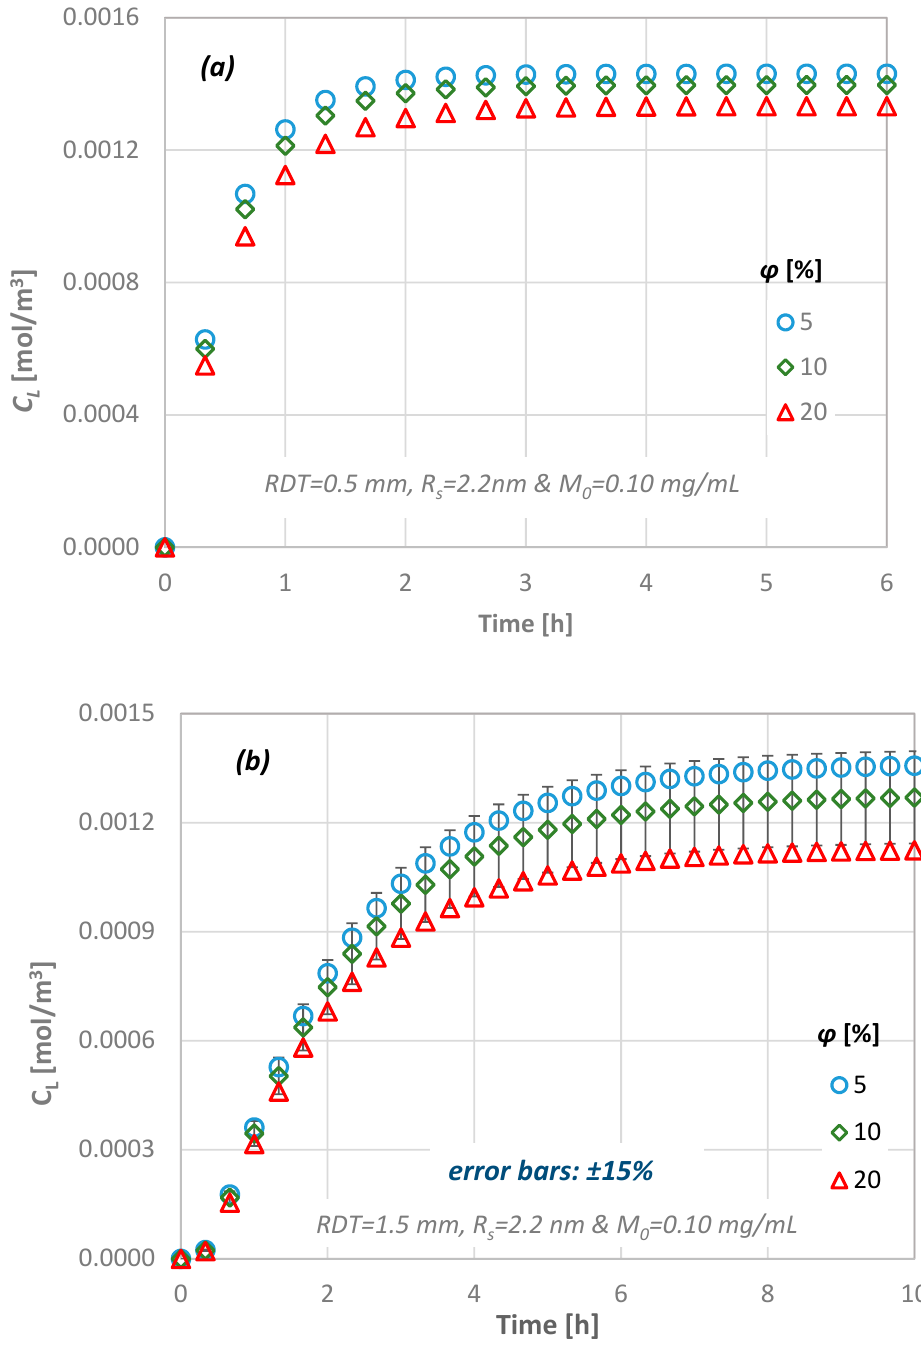
Figure 11. Effect of the dentinal disc porosity value on the diffusion characteristics for: ( a ) RDT = 0.5 mm, R s = 2.2 nm and ( b ) RDT = 1.5 mm, R s = 2.2 nm.